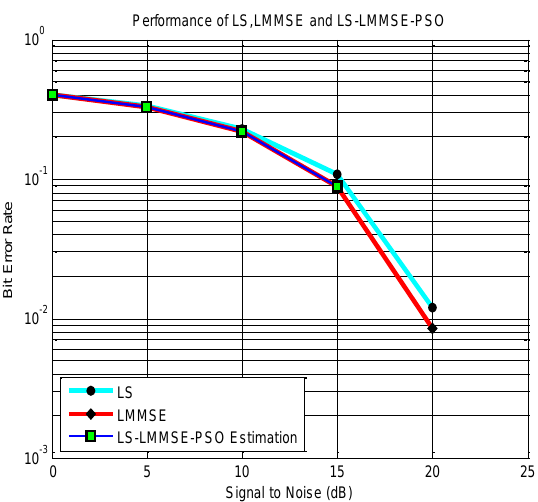
Figure 5: BER v/s SNR at Doppler frequency – 400 Hz